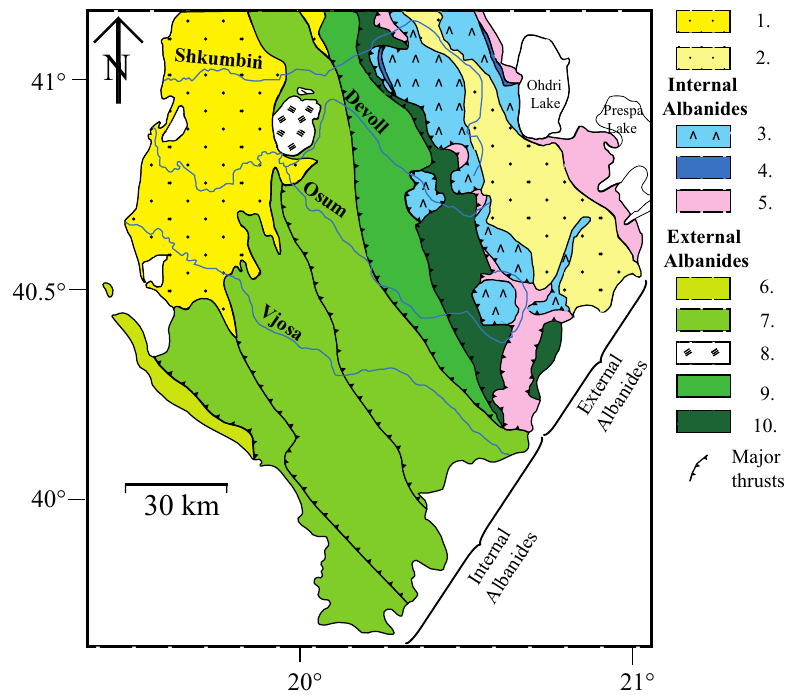
Figure 2. Simplified geologic map of Albania showing main tectonostratigraphic units (modified from Robertson and Shallo [2000], SHGJSH [2003] and Muceku et al. [2008]). Map legende: 1. Periadriatic depression (Neogene - Quaternary siliciclastic sediments); 2. Neogene - Quater- nary graben system (Neogene - Quaternary siliciclastic sediments) 3. Mirdita (Jurassic ophiolites); 4. Rubiku (Triassic shallow water carbonates); 5. Korabi (Triassic - Jurassic ophiolitic melange/ flysch/ debris flow); 6. Sazani (Triassic to Paleogene platform carbonates); 7. Ionian (Triassic to Paleogene platform and pelagic carbonates covered by Oligocene to Miocene flysch); 8. Ionian (Triassic evaporites). 9. Kruja (Mesozoic plat- form carbonates covered by Oligocene-Miocene); 10. Krasta-Cukali (Mesozoic platform carbonates covered by Cretaceous to Eocene